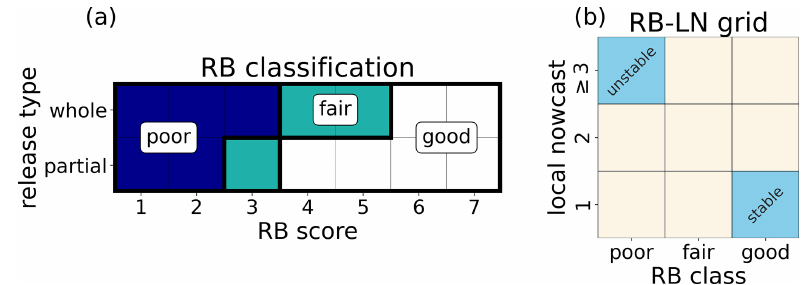
Figure 2. (a) Definition of the RB stability classes poor, fair and good in dependence on RB score and release type. (b) Classification of profiles into nine classes of a rutschblock stability–local nowcast (RB–LN) grid. The classification model was trained on DAV profiles belonging to either the upper-left or the lower-right classes (in